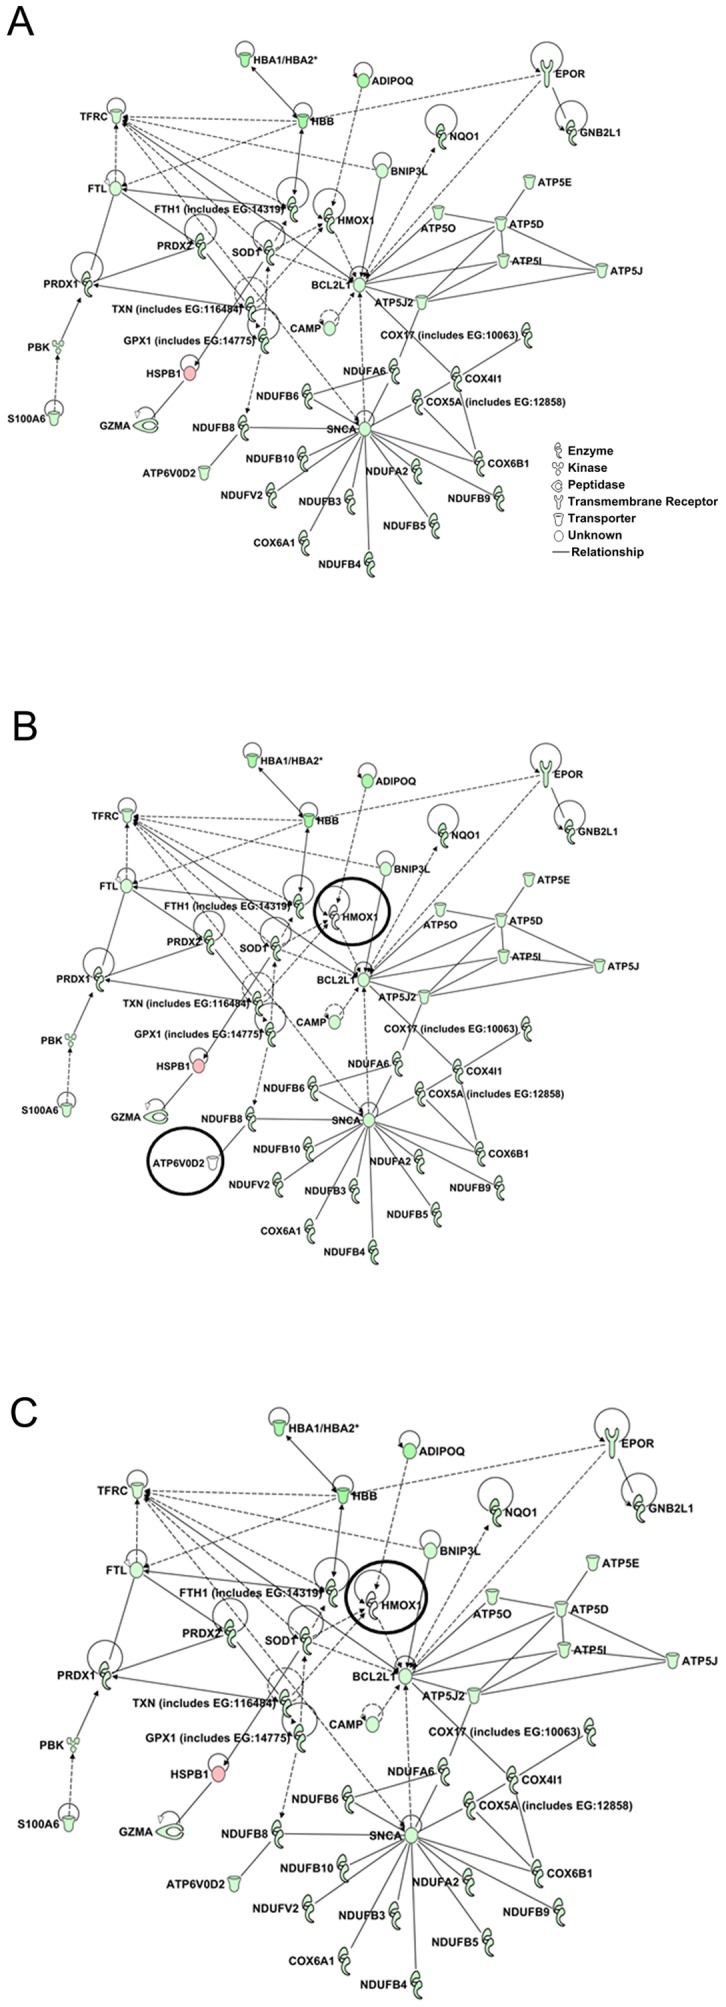
Spleen core DEGs forming network of mitochondrial dysfunction, oxidative phosphorylation, and ubiquinone biosynthesis.The network consists of 50 mitochondrial genes related to dysfunction, oxidative phosphorylation and ubiquinone biosynthesis. Genes colored with green or red indicate altered expression in saline-treated 9V/null spleen. Genes circled in black indicate the expression at WT level. (A) In the saline-treated 9V/null spleen, all genes in the network were abnormally expressed, shown in green or red. (B) The expression level of genes in imig-treated spleen. The ATPase and heme oxygenase circled in black were at WT levels. (C) In vela-treated spleen the expression of ATPase (circled in black) was at WT levels. Red indicates expression above normal and green indicates expression below normal levels.